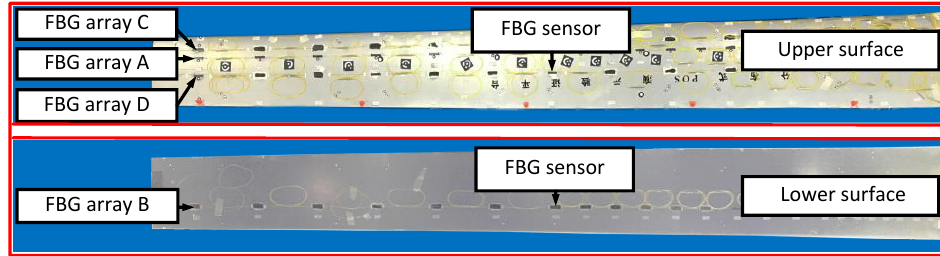
Figure 8. Wing model pasted by FBG sensors.